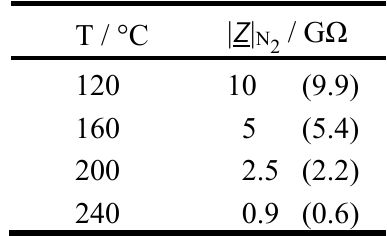
O)) of a planar Fe-BTC IDE sensor at 2